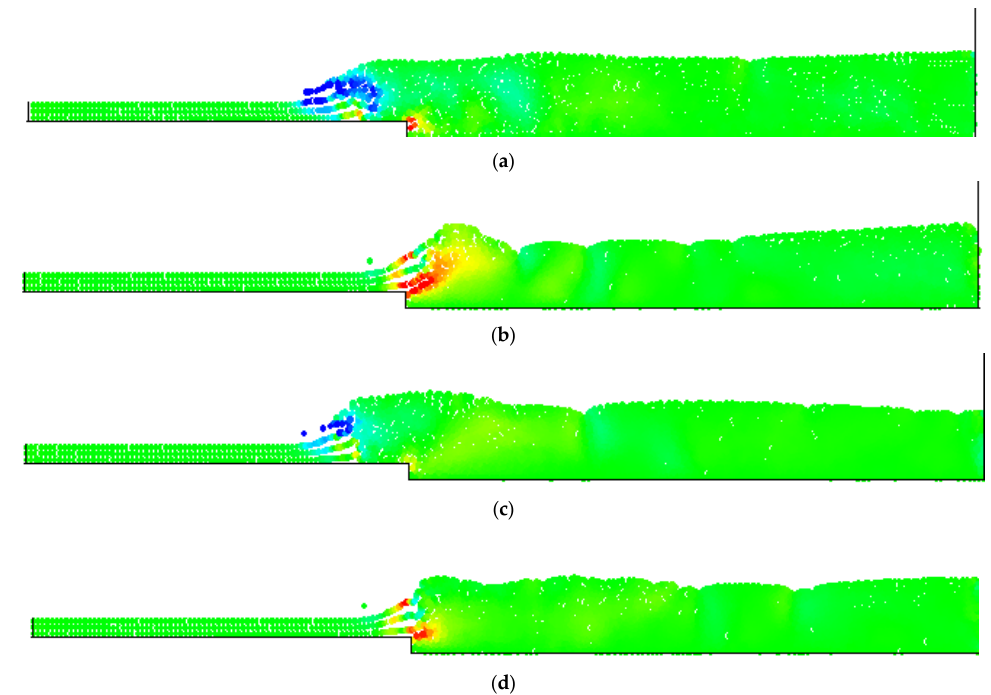
Figure 12. Instantaneous SPH vorticity field in the SPH simulation of Test T2: ( a ) t = 5 s; ( b ) t = 10 s; ( c ) t = 12 s; ( d ) t = 16 s; Colour scale is the same as in Figure 7.